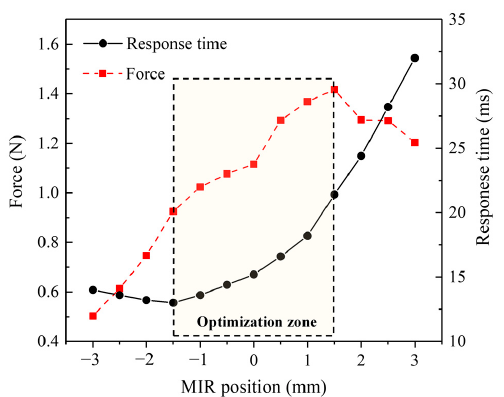
Figure 8. Variation curve of electromagnetic force and response time with MIR